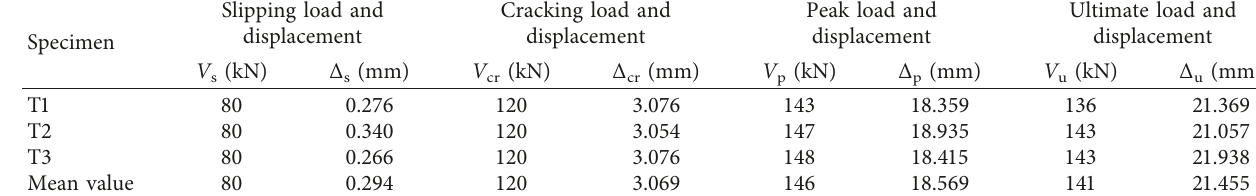
Table 1: Results of the tensile test.